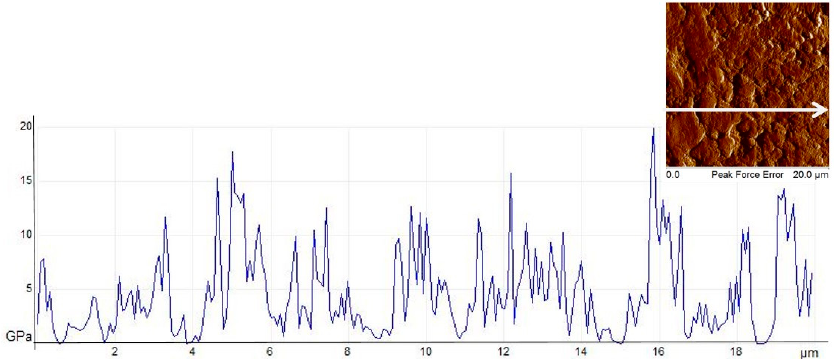
Figure 15. EM linescan across the varnish layer. Peak force error image in insert shows the points measured. Initial position is located near the interphase with the paint layer.